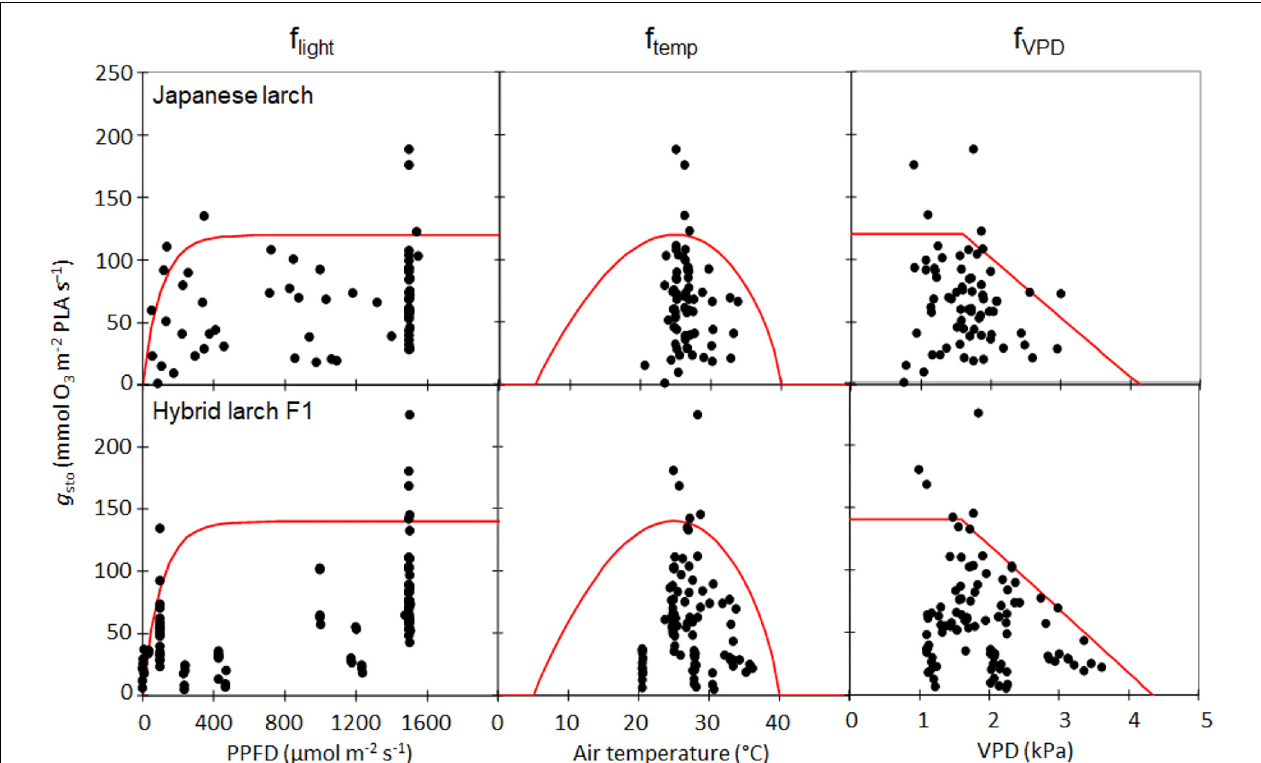
FIGURE 1 | Parameterization of the stomatal conductance ( g sto ) model for Japanese larch (above) and its hybrid F 1 (below), where f light , f temp , and f VPD are functions of photosynthetically photon flux density ( µ mol photons m − 2 s − 1 ), air temperature (T, ◦ C), and vapor pressure deficit (VPD, kPa), respectively. The results of the boundary line analysis are shown in